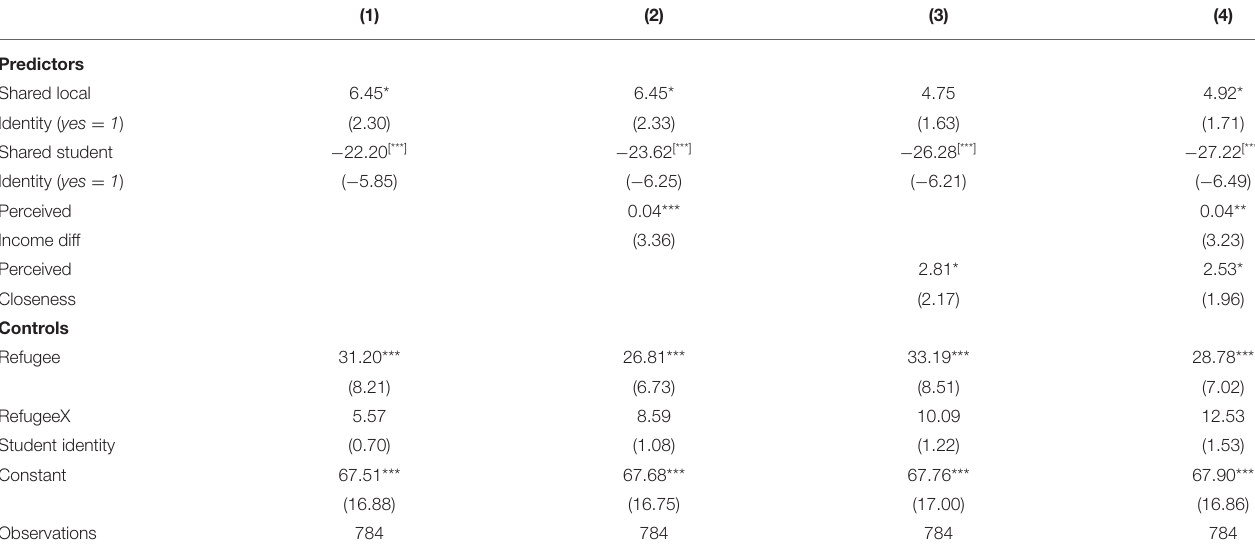
TABLE 1 | Altruistic giving predicted by the main predictors shared local identity and shared student identity (column 1), perceived income differences (column 2) and closeness (column 3) and all main predictors (column 4) for the overall